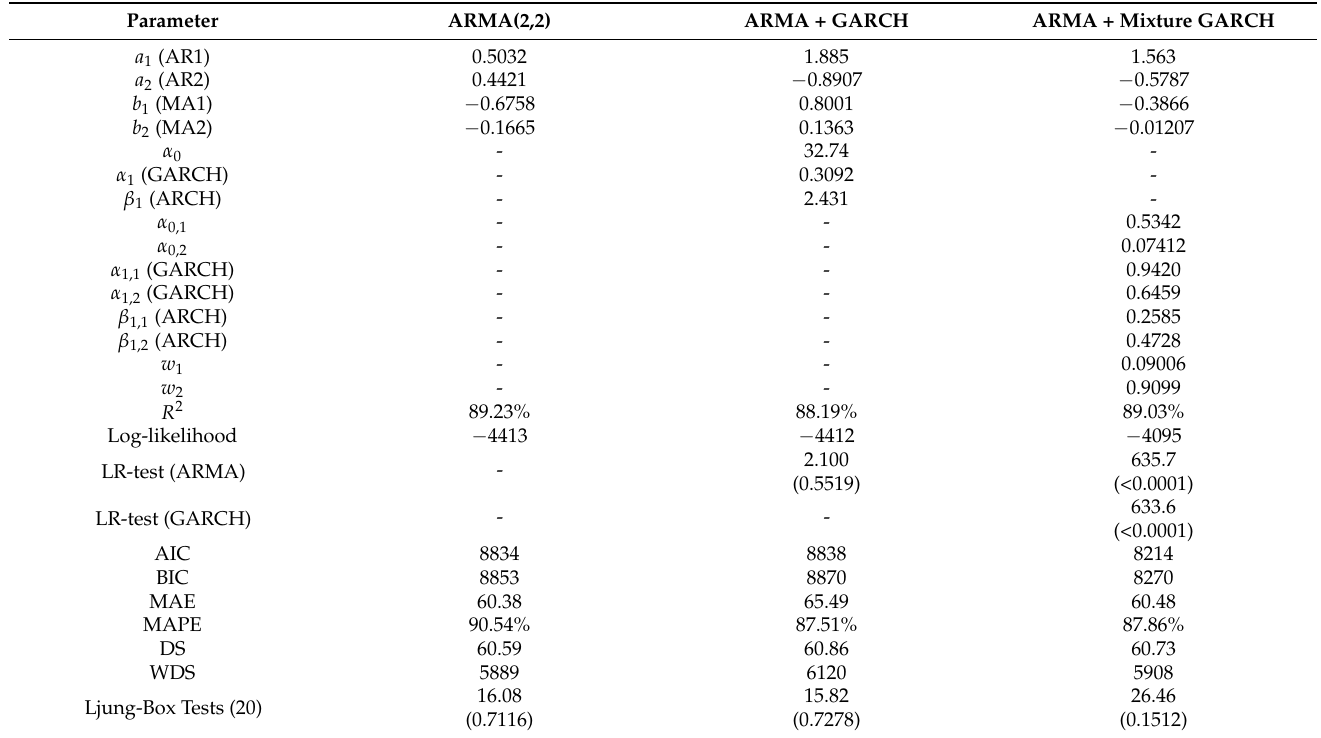
Table 6. Estimated parameters and performance measures for the third wind generation